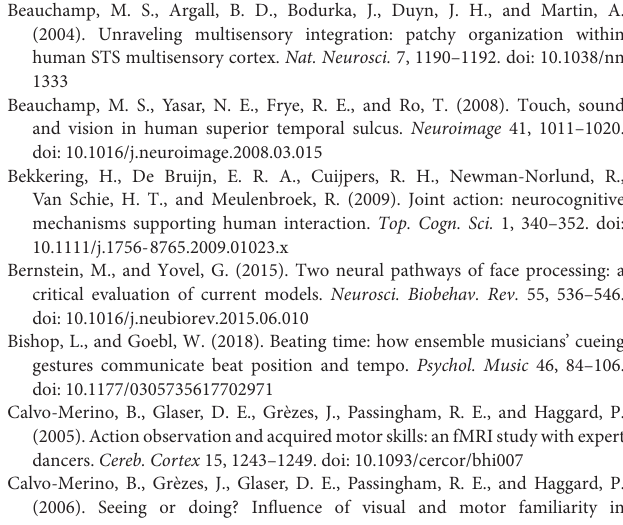
FIGURE S1 | Optode setup overlaid onto the 10–20 international system. Sources are depicted in red, detectors in blue, and channels in green. FIGURE S2 | Individual beta values of the group comparison between duo versus solo when playing as Violin 1 and Violin